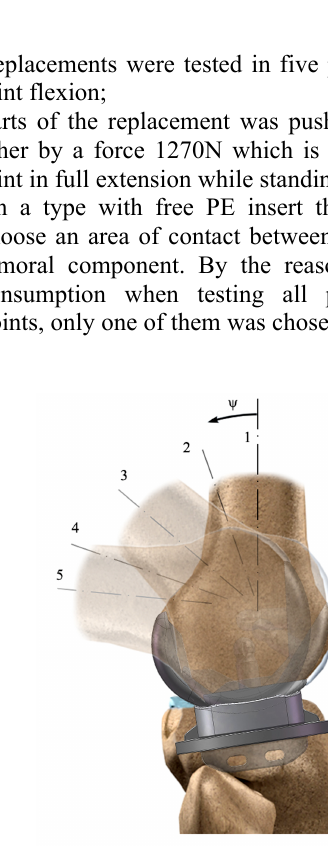
Fig.3. Five testing positions shown on knee joint